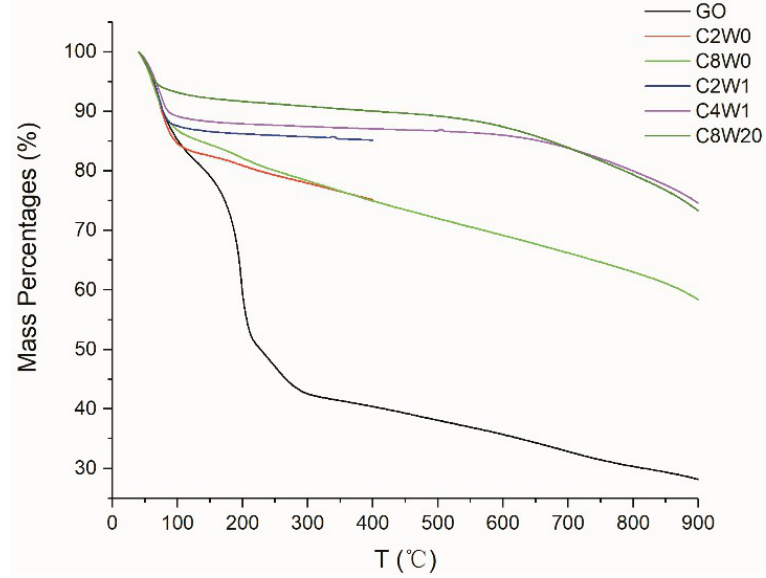
Figure 4. Thermogravimetric analysis (TGA) curves of different samples.